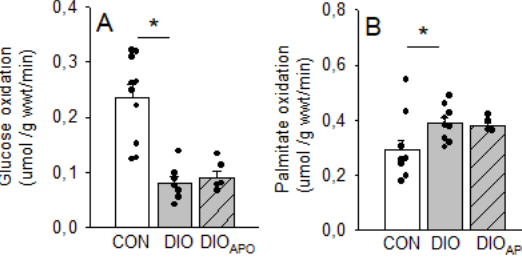
Figure 5. Glucose ( A ) and palmitate ( B ) oxidation rates measured in isolated working hearts from lean controls (CON), diet-induced obese (DIO), and obese apocynin-treated (DIO APO ) C57BL / 6J mice fed an obesogenic western diet for 18 weeks. Single values and mean ± SEM, * p < 0.05 vs.